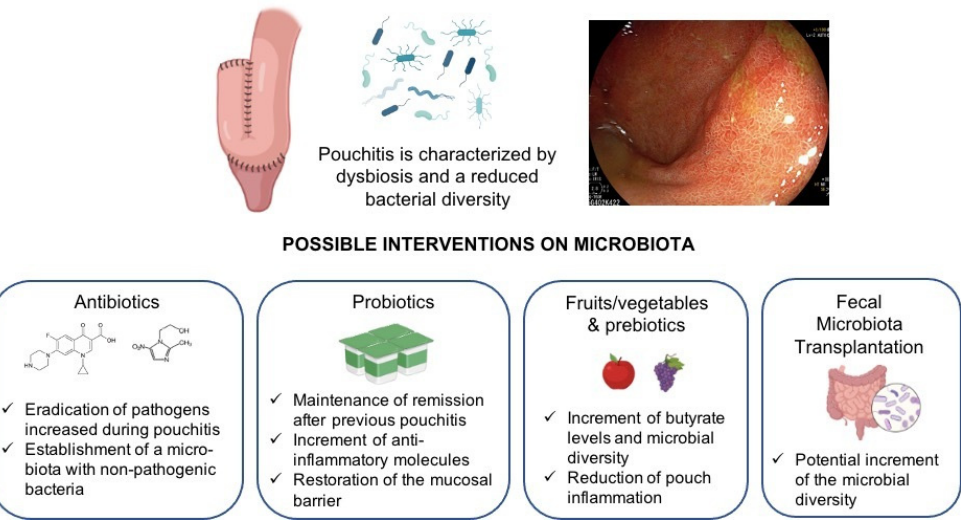
Figure 1. Interventions in the microbiota for the treatment of pouchitis. Antibiotic treatment (i.e., ciprofloxacin) may reduce the aerobic and pathogen bacteria (which are increased during pouchitis) while leaving undisturbed the larger part of the anaerobic flora, which is present in high numbers in subjects free of pouchitis [36]. Treatment with probiotics can increase fecal concentrations of anaerobes [70,75] and can decrease the levels of the Escherichia subgroup [75]. Pouch microbial diversity is also positively correlated with fruit consumption. In addition, the intake of fruit is positively correlated with the presence of Faecalibacterium and Lachnospira [88]. Finally, the treatment of pouchitis with fecal microbiota transplantation may increase the microbial diversity with a switch towards the donor’s microbiota [78]. Table 3. Studies evaluating the interventions on the microbiota as a therapeutic target of pouchitis.